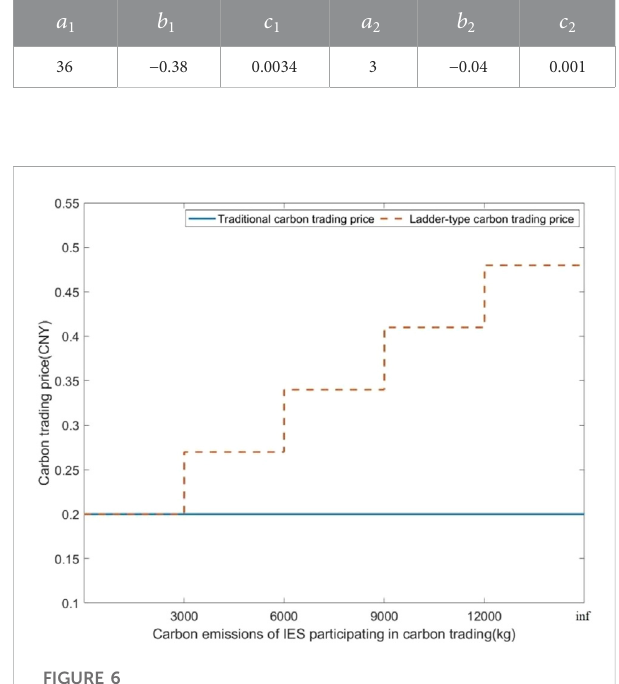
FIGURE 6 Traditional carbon trading price and ladder-type carbon trading